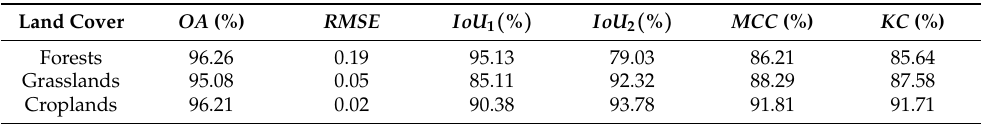
Table 8. Performances in different land use